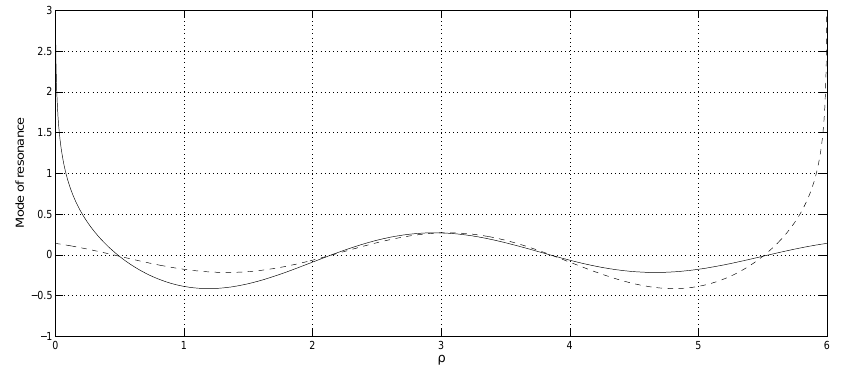
Figure 15. Scaled mode shape resonance due to load with non-dimensional a 0 = 5.53 when the loss factor η = 0.0 and E = 9411 KPa.